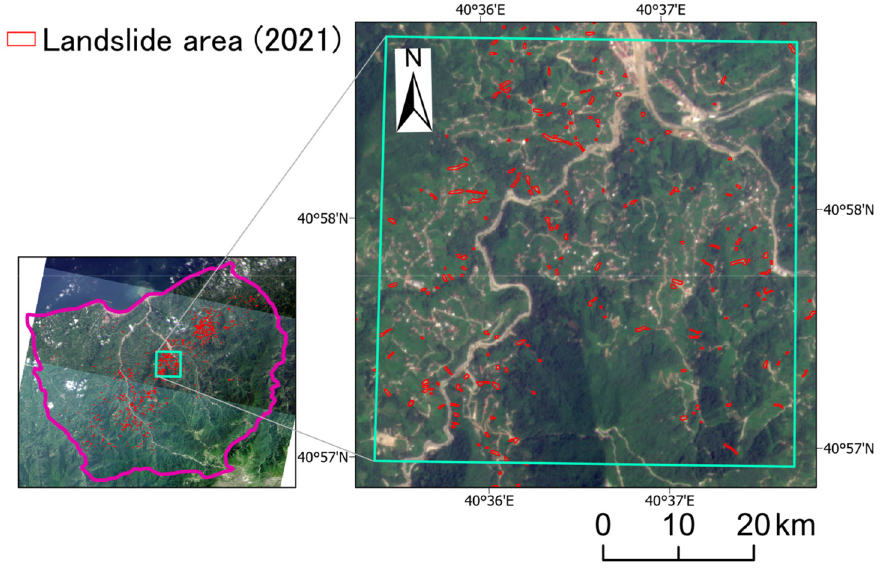
Figure 8. Quantification theory type II analysis of the area (satellite image is acquired from PlanetScope [30]). Table 8. Result of quantification theory type II analysis.